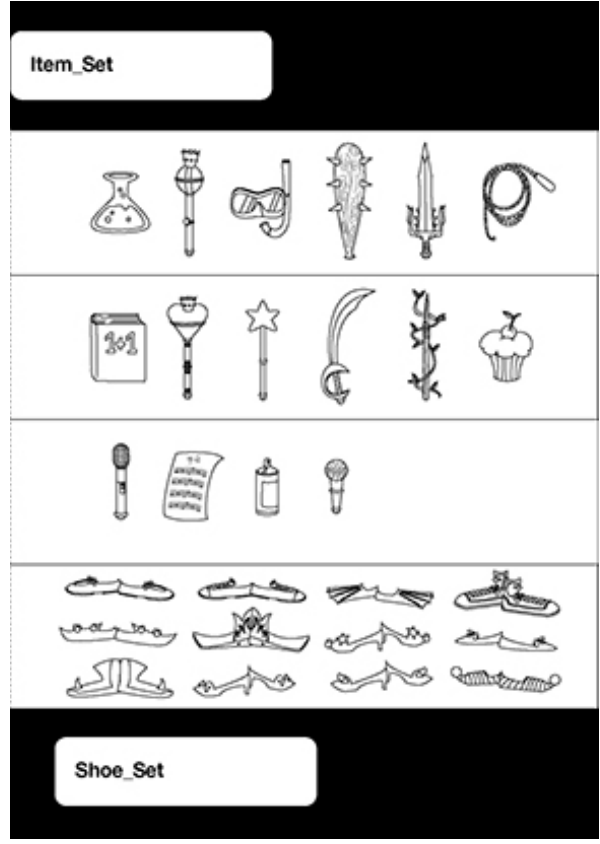
graphic project made by Giacomo Guccinelli and Lucrezia Ben- venuti; Locritani et al.,